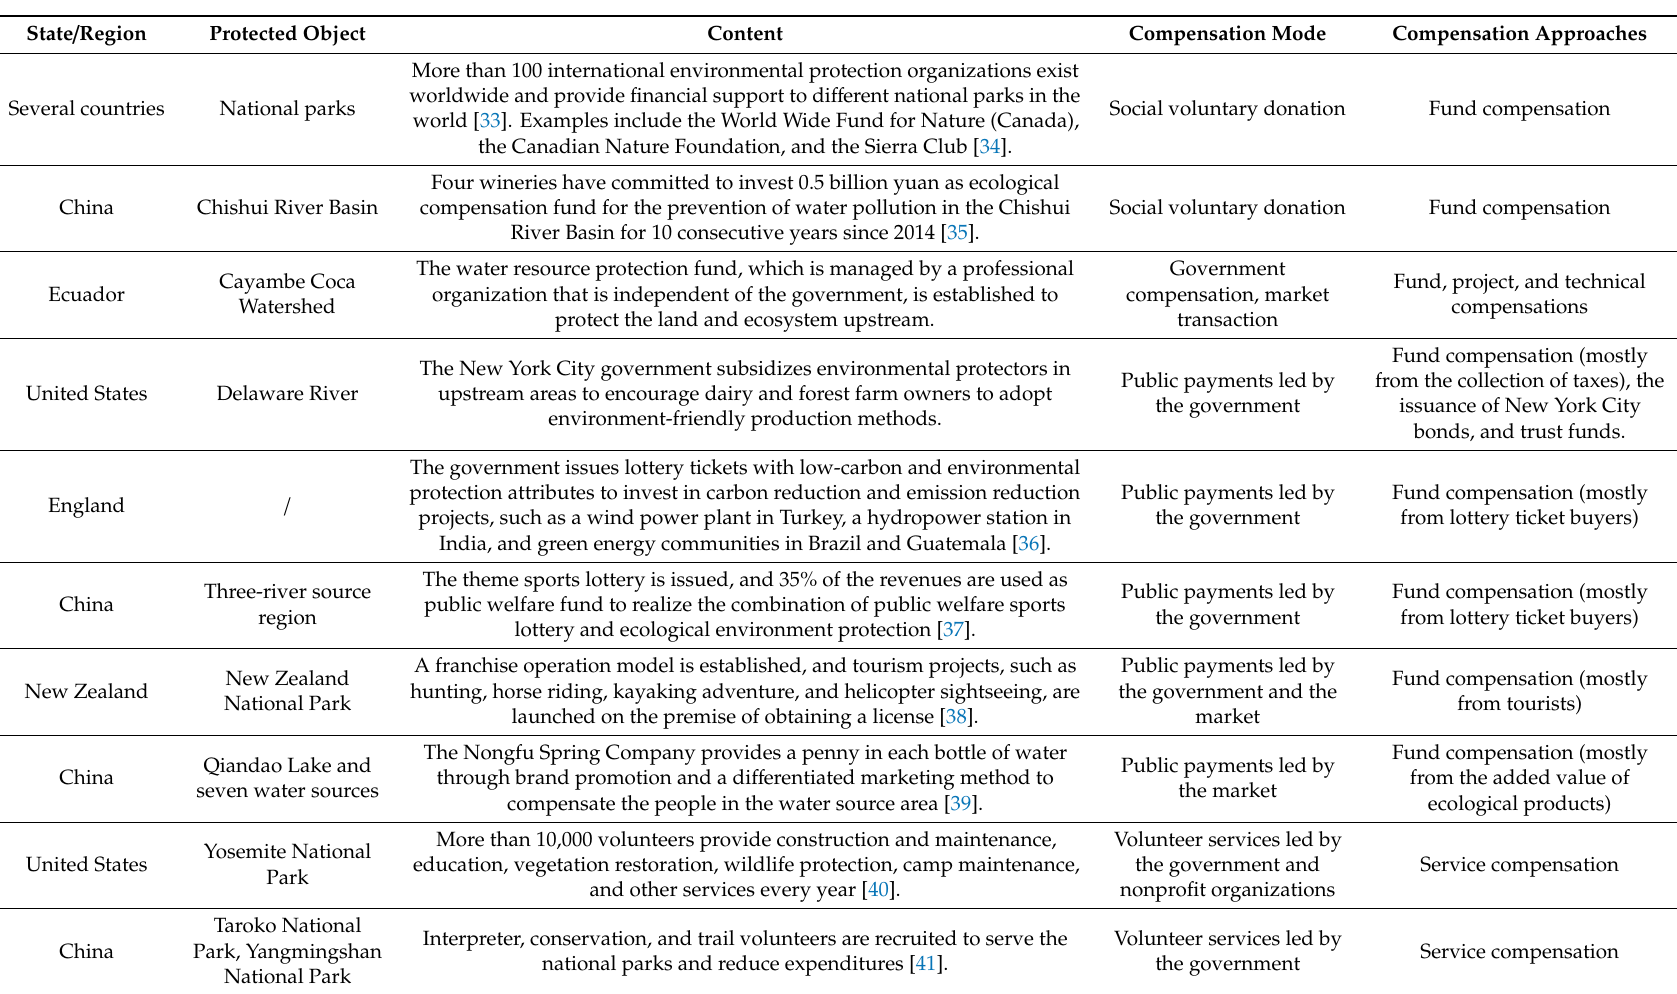
Table 1. Ecological compensation cases of typical river basins and nature reserves in China and other